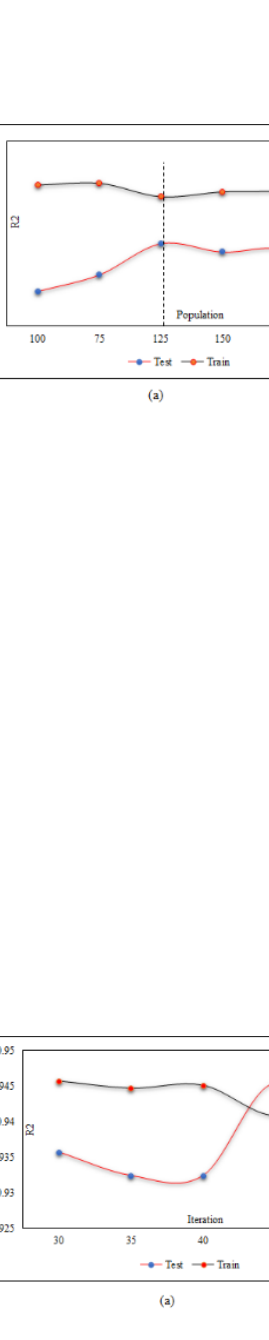
Figure 21. MPF adjustment based on the iteration number: ( a ) effect of the iteration number on ( R 2 ), ( b ) effect of the iteration number on (r), and ( c ) effect of the iteration number on ( RMSE ). Table 9. The calculated accuracy criteria for the performance of the implemented models (Popula- tion = 125).